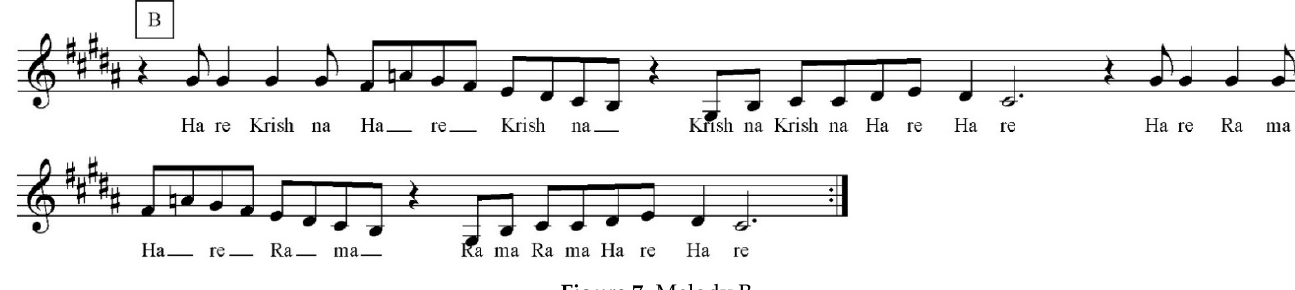
Figure 7. Melody B. Figure 7. Melody